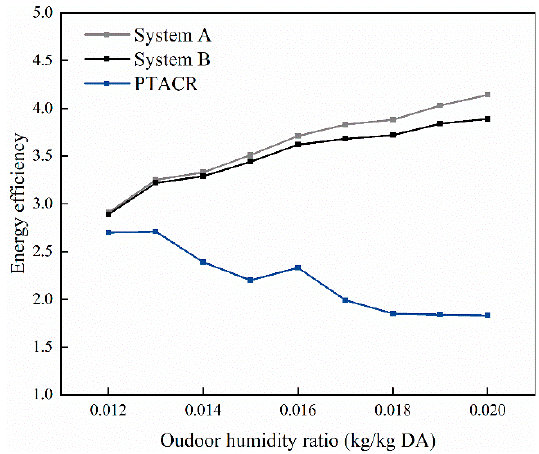
Figure 10. Variation of the 𝜀 (cid:3009)(cid:3017)(cid:3005)(cid:3004) and 𝜀 (cid:3017)(cid:3021)(cid:3002)(cid:3004)(cid:3019) with the outdoor humidity ratio.